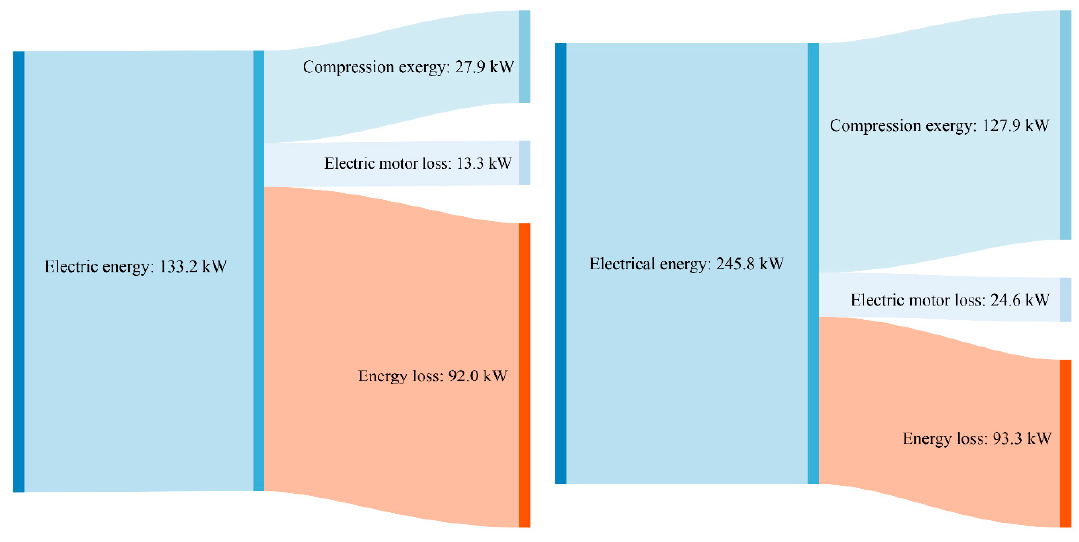
Figure 6. Sankey energy flow diagram for the lowest and highest measured turbo compressor load.